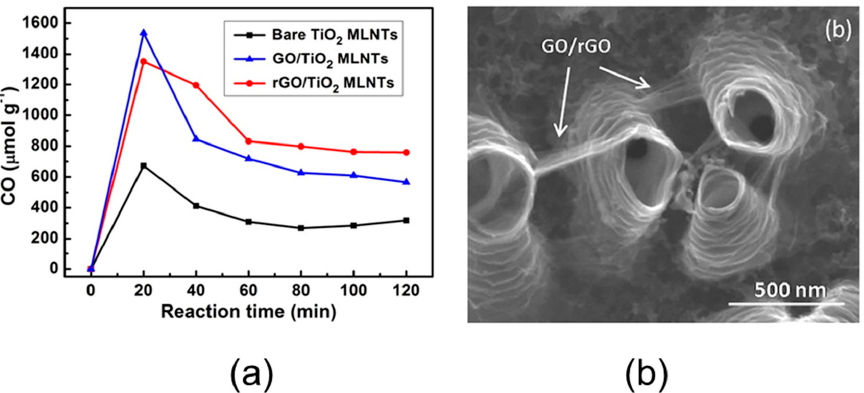
Figure 17. ( a ) The amount of carbon monoxide produced by the photocatalytic reduction of carbon dioxide from di ff erent composite materials. ( b ) Field Emission Scanning Electron Microscope (FESEM) images of rGO / TiO 2 nanotubes. Reprinted with permission from